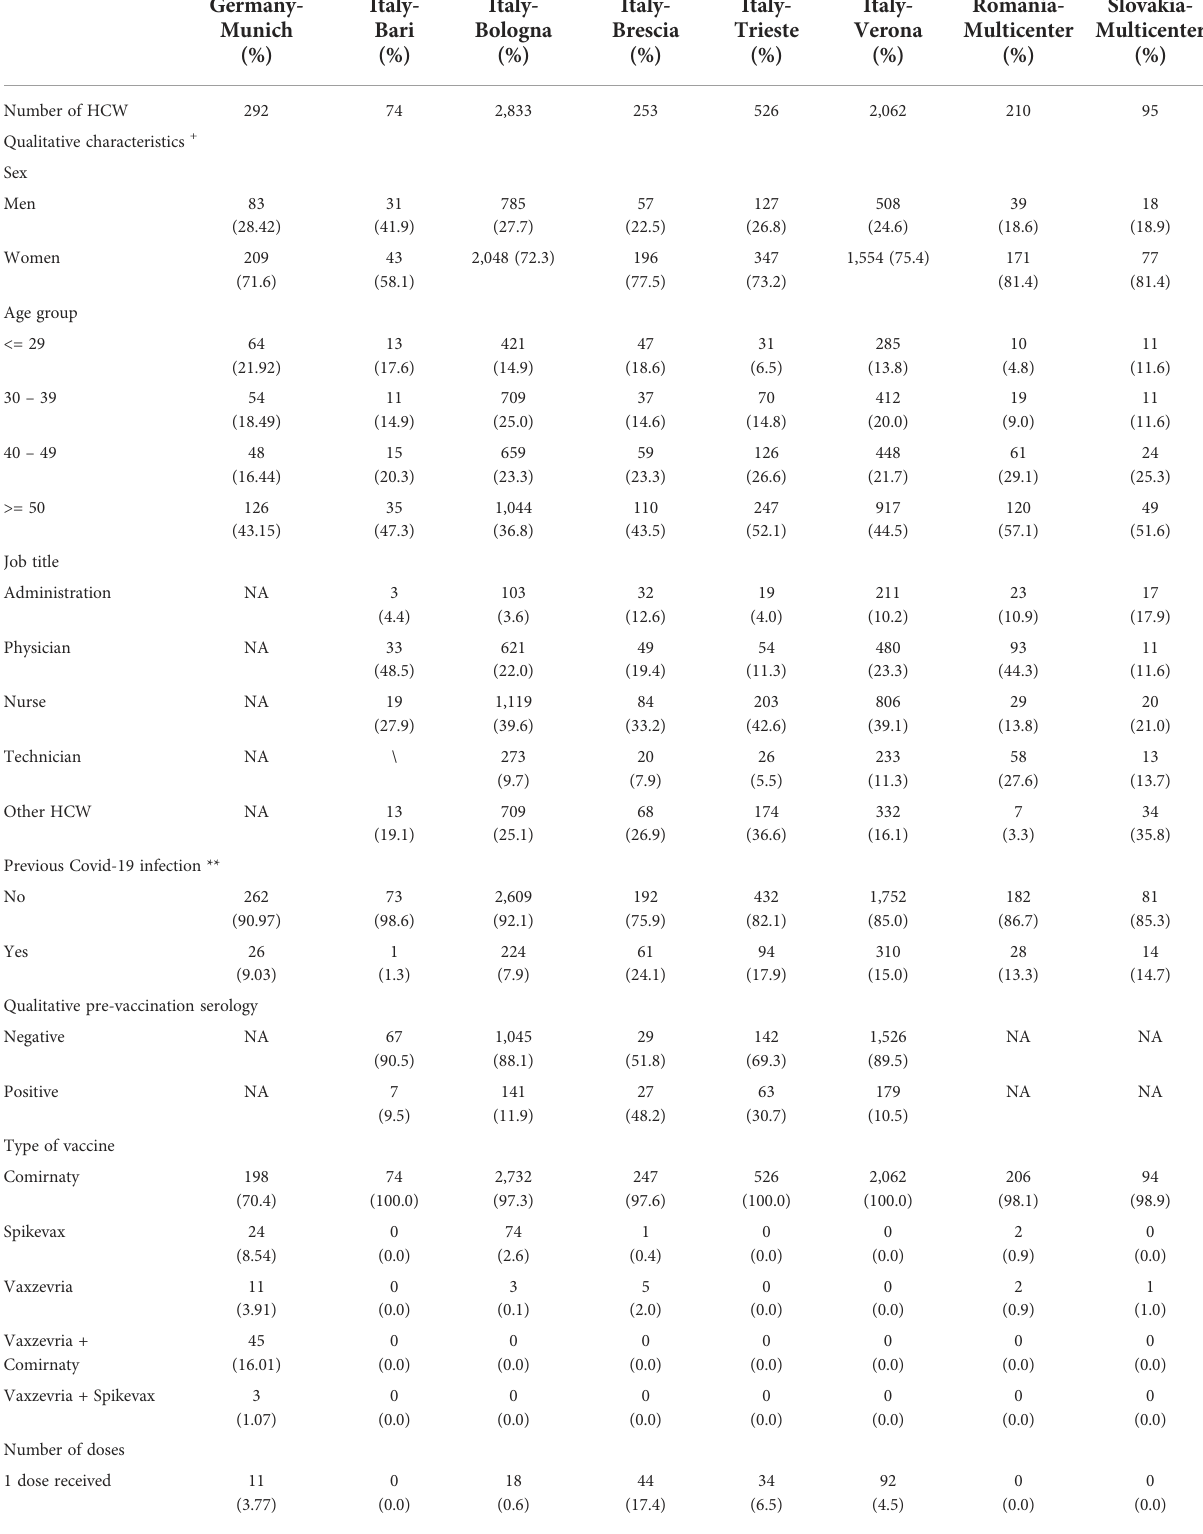
TABLE 2 Selected characteristics of HCWs included in the